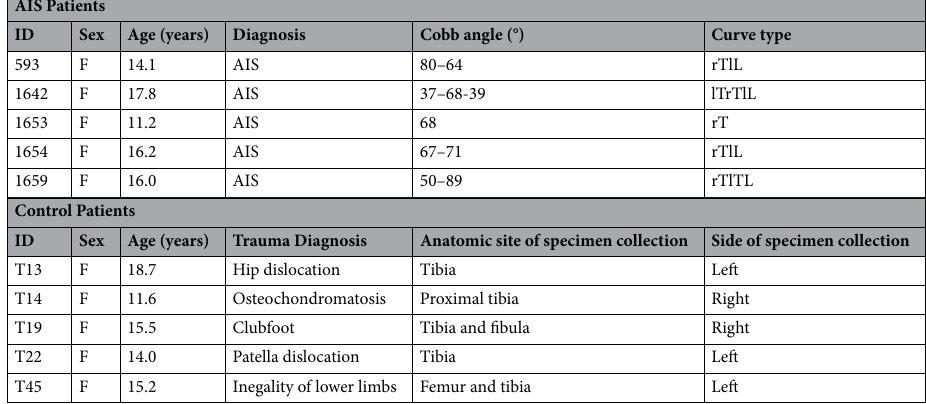
Table 2. Clinical and demographic data of patients. rTlL: Right Thoracic-Left Lumbar; lTrTlL: Left Thoracic- Right Thoracic- Left Lumbar ; rT: Right Thoracic ; rTlTL: Right Thoracic- Left